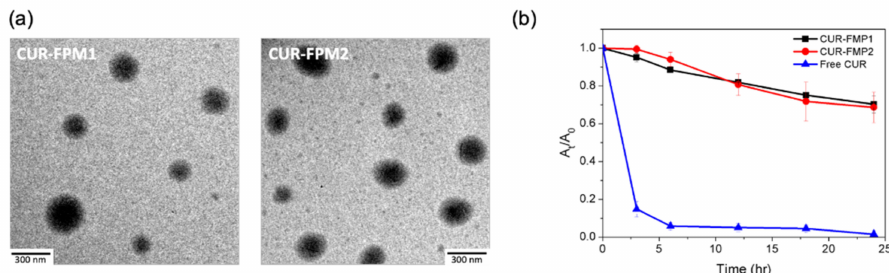
Figure 1. ( a ) TEM images of CUR-FPM micelles; ( b ) aqueous stability of free CUR and CUR-FPM micelles in PBS (pH 7.4) at 37 ◦ C. A 0 and A t are the absorbance of CUR at 428 nm initially and time t,